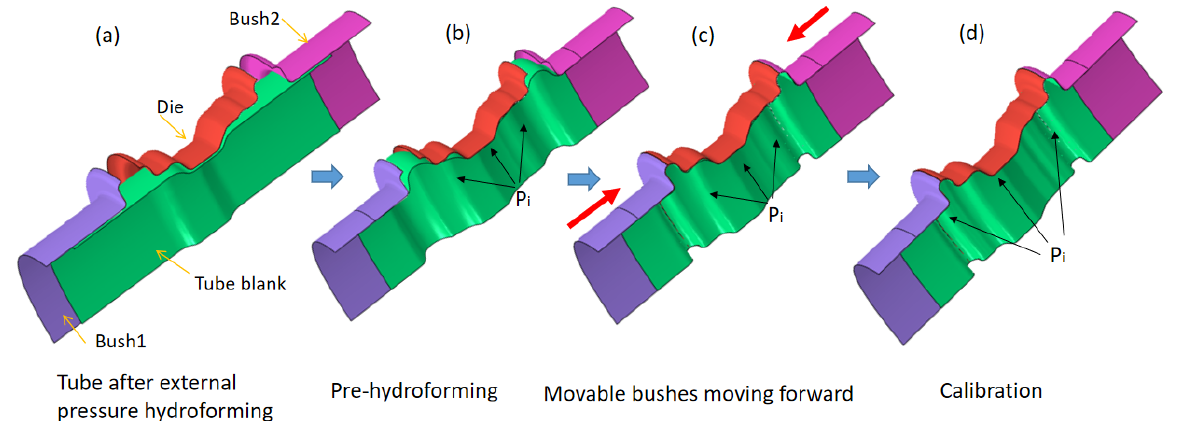
Figure 19. The process of the internal pressure stage with movable bushes: ( a ) before deformation, ( b ) pre-hydroforming, ( c ) movable bushes moving forward, and ( d ) calibration.